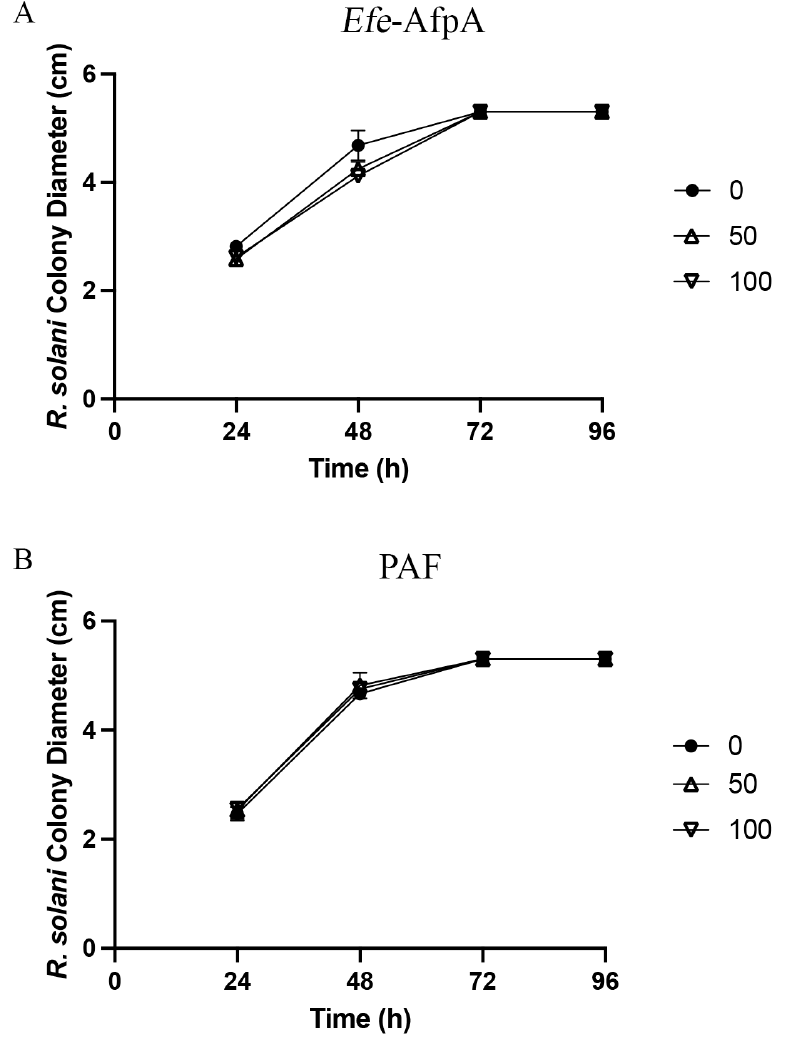
Figure 7. Activity of ( A ) Efe -AfpA and ( B ) PAF against R. solani mycelial growth. R. solani mycelial plugs were subcultured onto PDA plates amended with increasing concentrations of Efe -AfpA or PAF. The colony diameters were measured daily. The data presented are the means and standard deviations of three replicates.